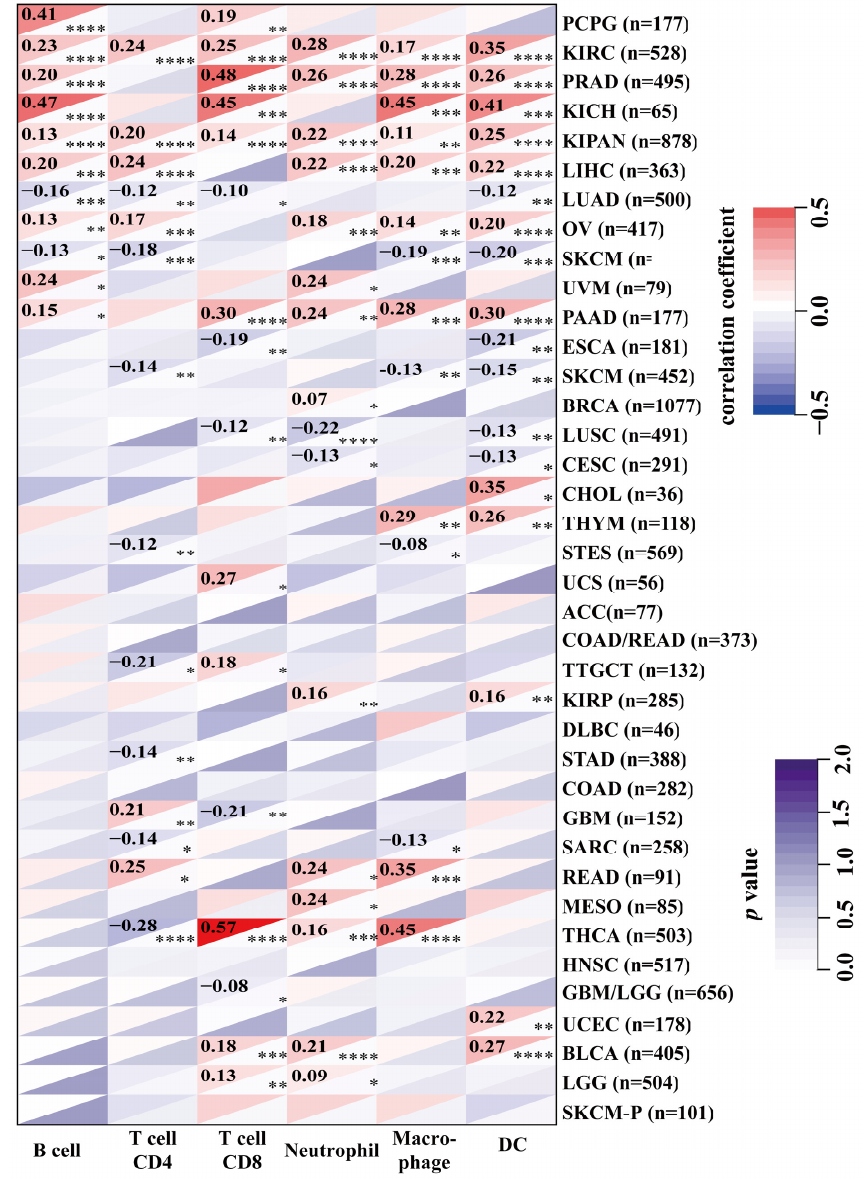
Figure 5. Association between NOL7 expression and immune infiltration levels in various immune cells in the TIMER2.0 database, as assessed using the Sangerbox tool. * p < 0.05; ** p < 0.01; *** p < 0.001; **** p <0.0001.